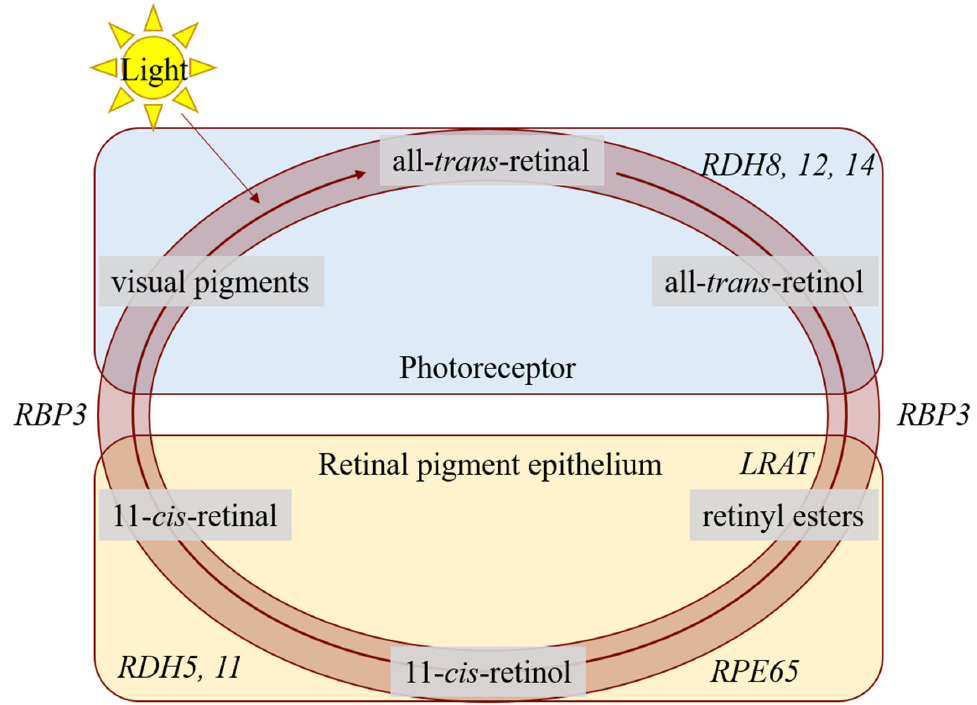
Figure 1. A schematic overview of the visual cycle in the photoreceptors (PRs) and the retinal pigment epithelium (RPE). In the PRs, 11 ‐ cis ‐ retinal couples to an opsin protein, forming rhodopsin. Upon activation by photons, 11 ‐ cis ‐ retinal is isomerized to all ‐ trans ‐ retinal. The retinol dehydrogenases (encoded by RDH8 , RDH12 , RDH14 ) reduce all ‐ trans ‐ retinal to all ‐ trans ‐ retinol, and this metabolite is moved to the RPE by retinoid ‐ binding protein (encoded by RBP3 ). In the RPE, it is esterified by lecithin:retinol acyltransferase (encoded by LRAT ), after which it is converted to 11 ‐ cis ‐ retinol by retinal pigment epithelium ‐ specific 65 kDa protein (encoded by RPE65 ). Retinol dehydrogenases (encoded by RDH5 and RDH11 ) convert 11 ‐ cis ‐ retinol to 11 ‐ cis ‐ retinal, and retinoid ‐ binding protein moves it back to the PR. For further explanation, see the text.